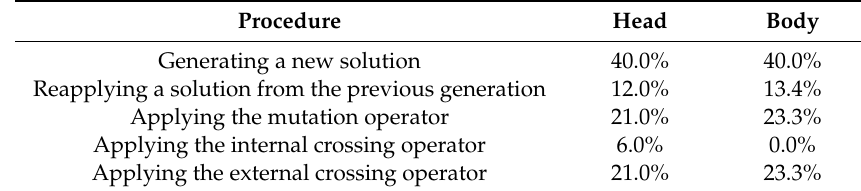
Table 1. Probabilities of using the five procedures to generate an individual for the next generation for the head and the body construction